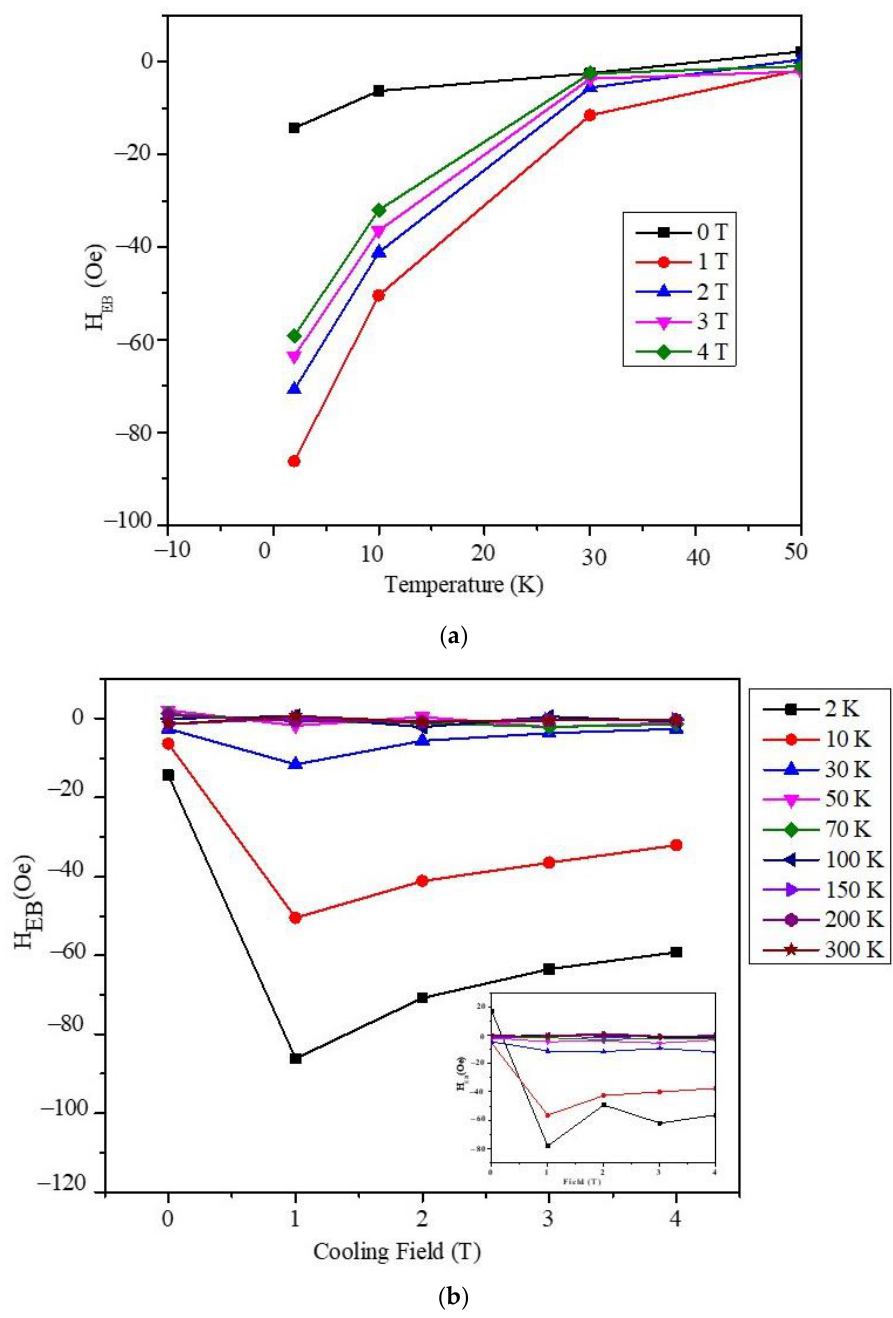
Figure 6. ( a ) Temperature-dependent exchange bias values under 0, 1, 2, 3, and 4 T field cooling. ( b ) Cooling field-dependent exchange bias values in the temperature range of 2 – 300 K (The inset is the cooling field-dependent exchange bias field values of undoped maghemite nanoparticles).